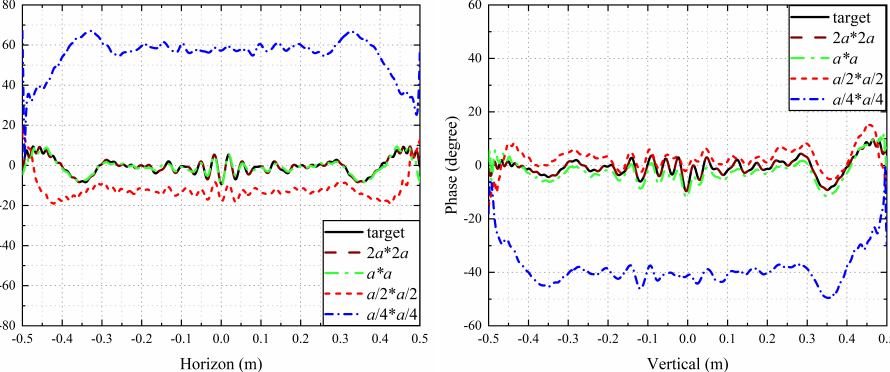
Figure 14. The comparison between the target phase and the phase retrieved by the GS/HIO algorithm with the sampling area of the plane S 2 reduced in different proportions.